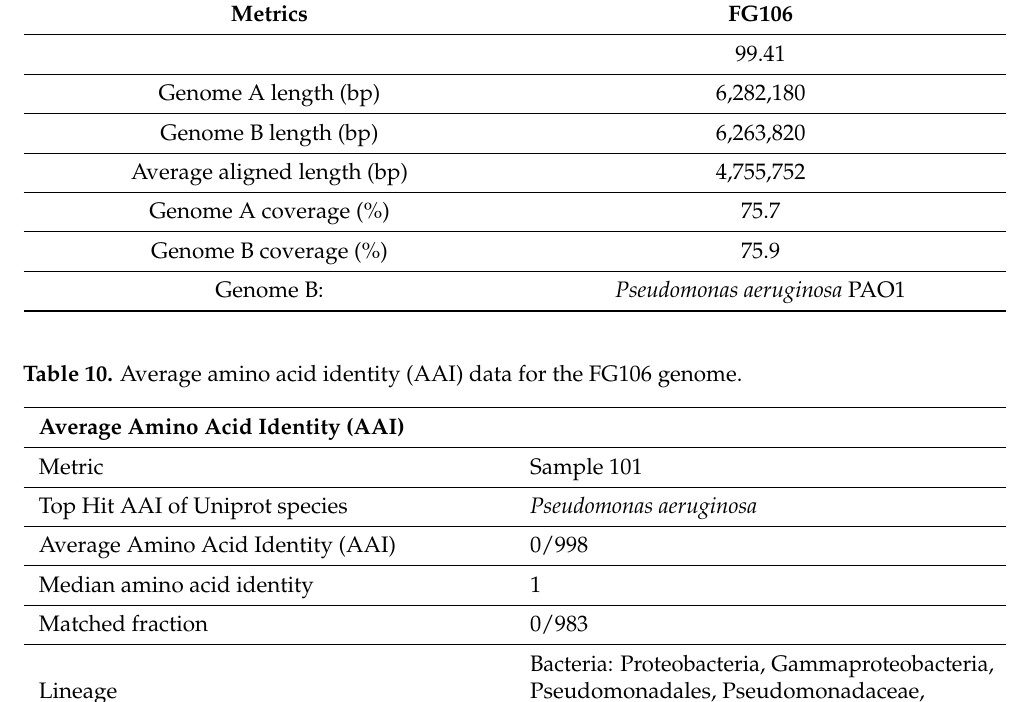
Table 9. Average nucleotide identity (ANI) based on a comparison of the FG106 genome to that of P. aeruginosa PAO1.